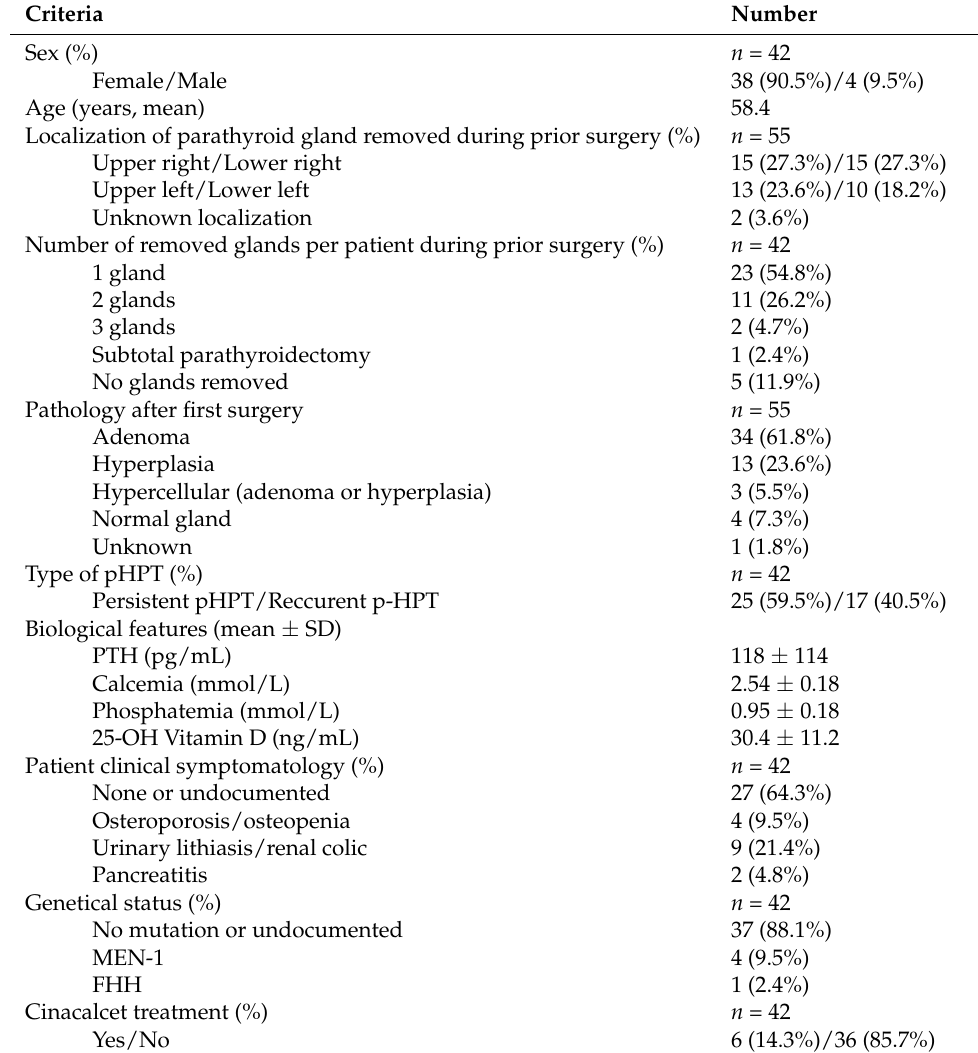
Table 1. Overview of the clinical and biological characteristics of the included